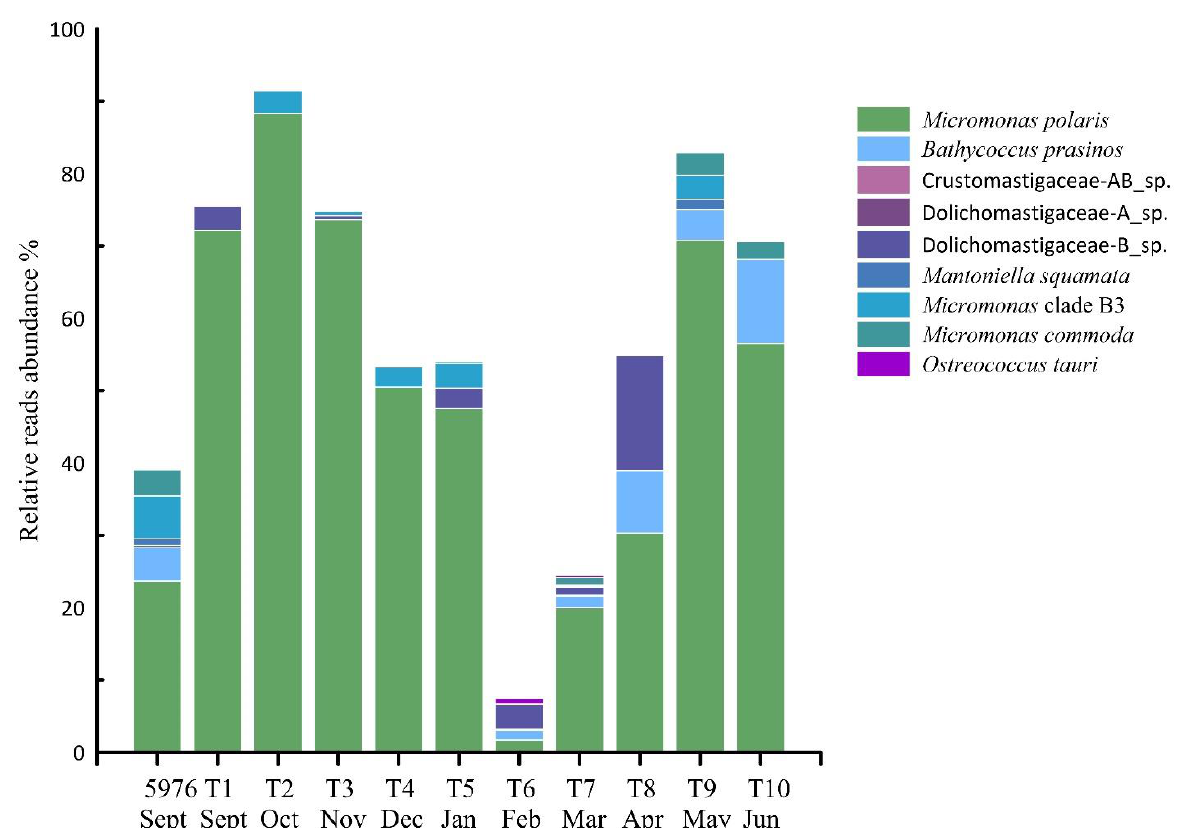
Figure 7. The contribution (%) of Mamiellophyceae phylotypes to total PE reads in studied samples. Trebouxiophyceae was the second Chlorophyta class that was found in all trap sam- ples and accounted for, on average, approximately 17% of the PE reads. Choricystis sp. and Picochlorum sp. were the most abundant and occured in all seasons, and their greatest contribution to total PE reads was found in samples T4–T7 at an average of 8% and 28%, respectively. Three more Trebouxiophyceae phylotypes, Neocystis brevis , Botryococcus sp., and Chlorella sp., were identified at low abundances in only a few samples. Trebouxio- phyceae were not found in water sample